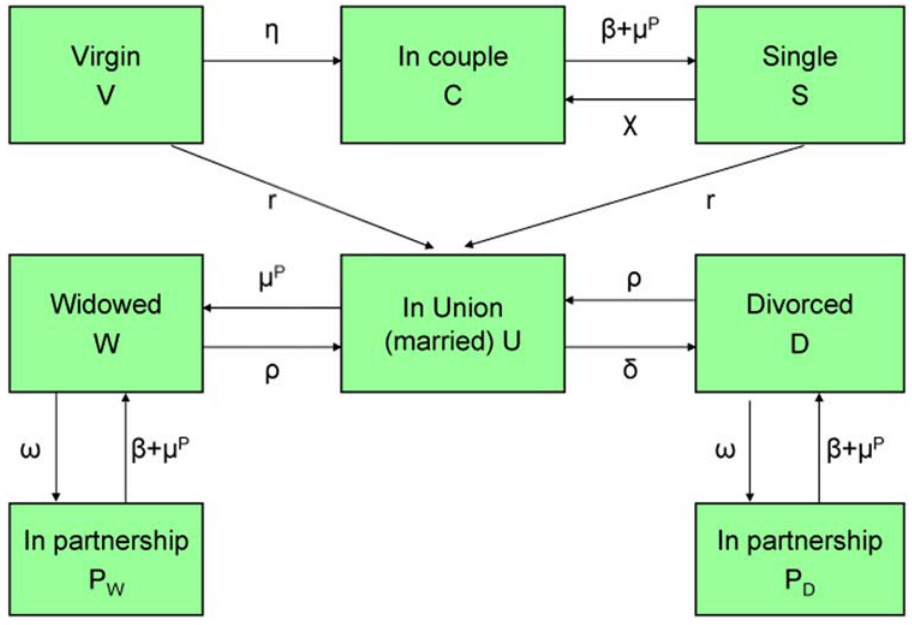
Figure 1. Transition scheme of marital statuses (both sexes).